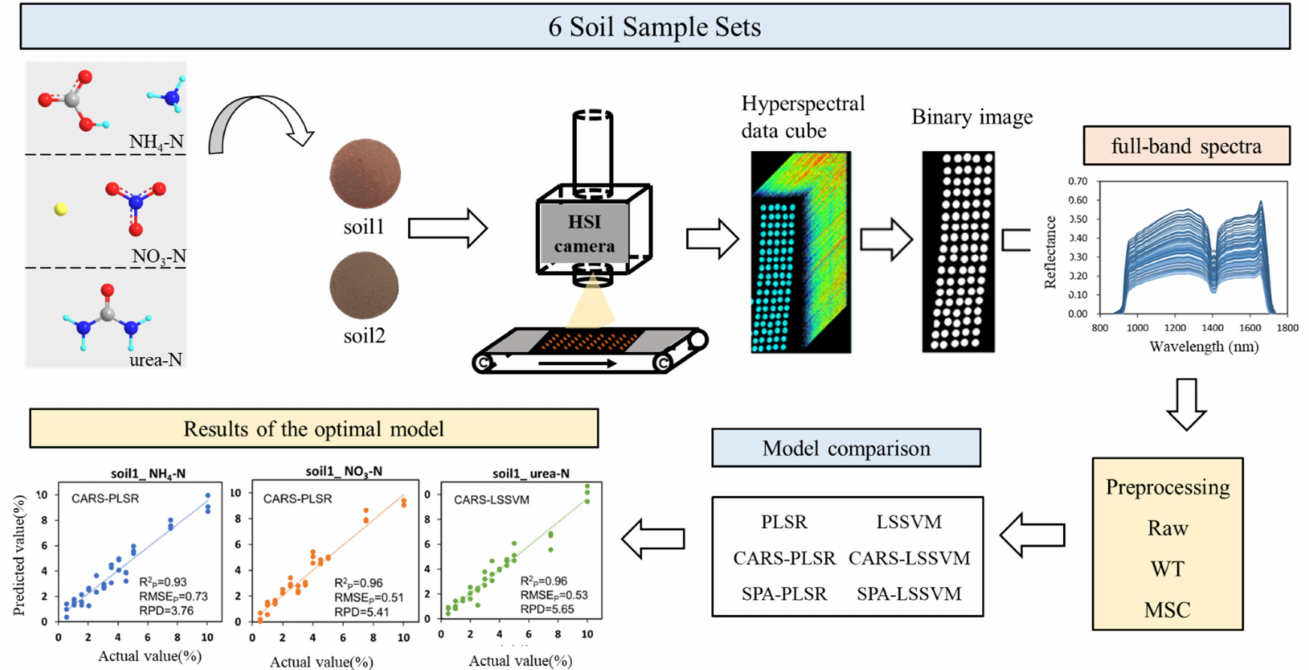
Figure 6. Flowchart of image collection and data